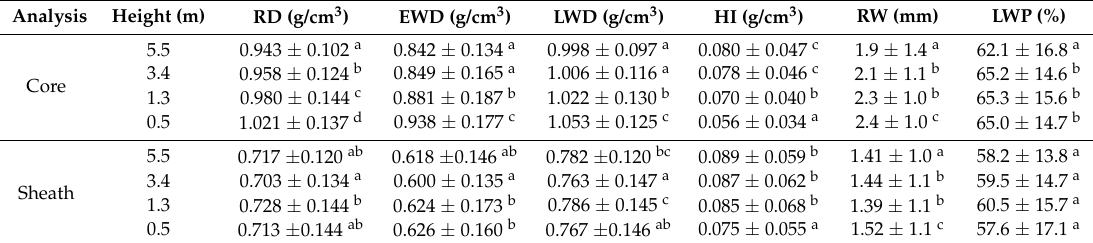
Table 5. Mean values ( ± standard deviation) for the wood density components and ring width within the core and sheath analyses by tree height levels at both sites (RD, ring density; EWD, earlywood density; LWD, latewood density; HI, heterogeneity index; RW, ring width; and LWP, latewood percentage).